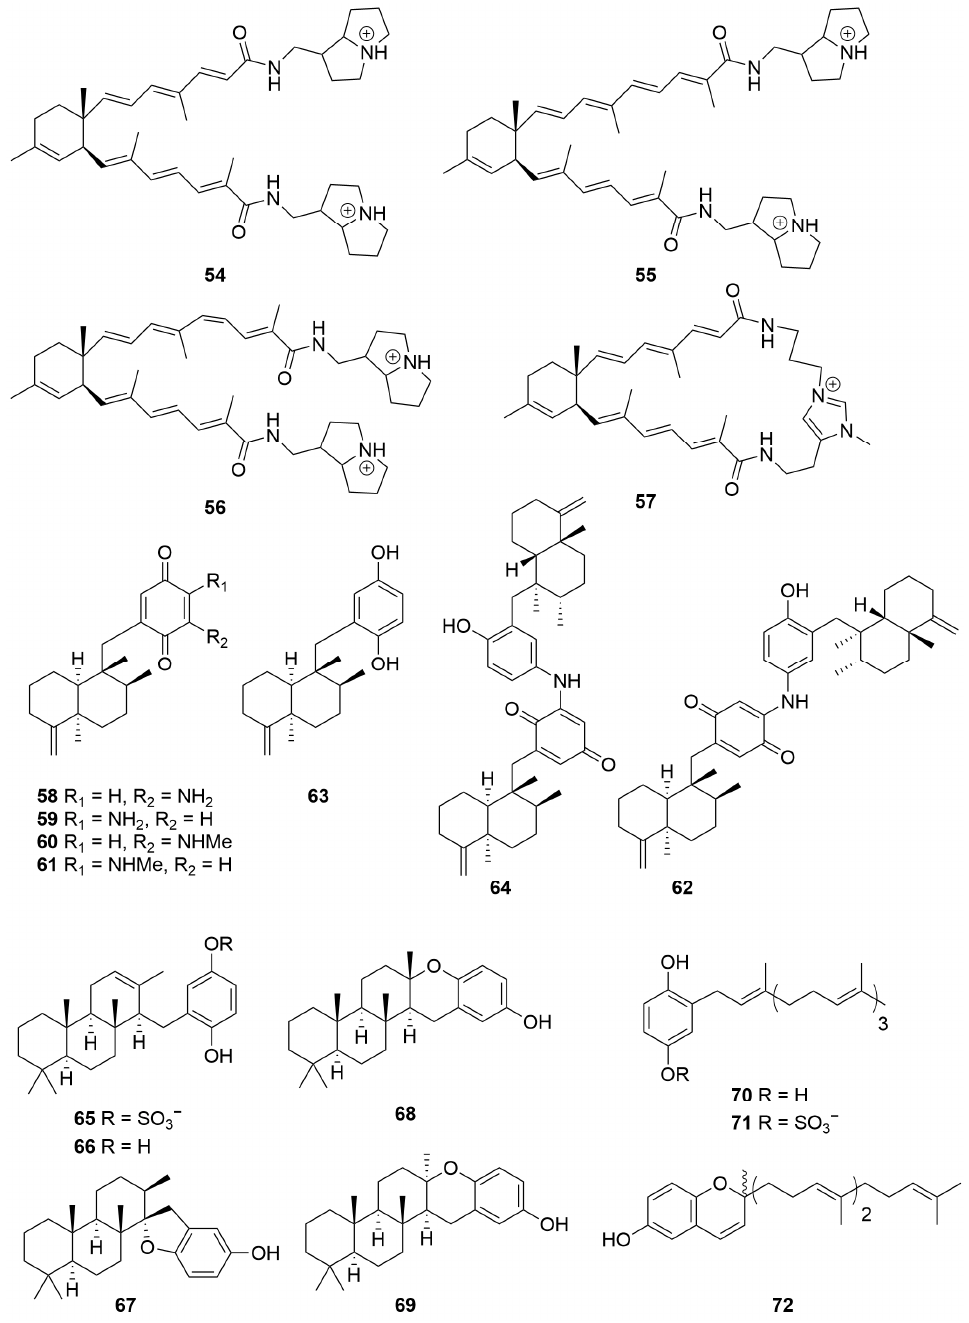
Figure 4. Compounds 54 to 72